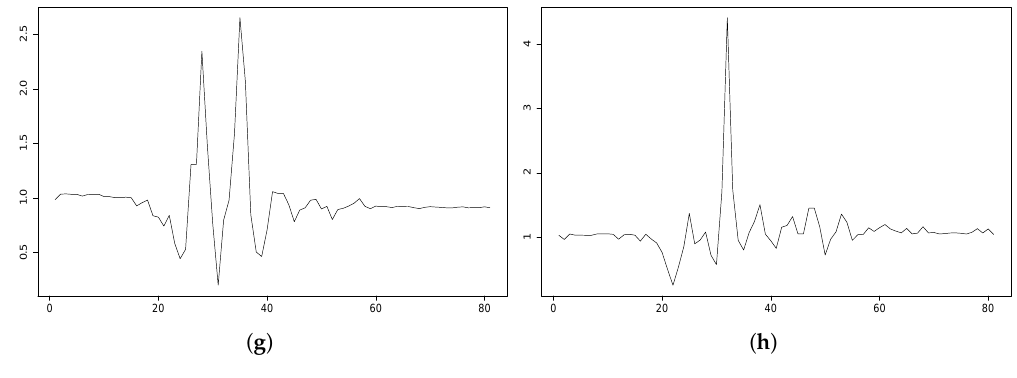
Figure 6. UMA Fall plots for some falls that behave differently from what was expected. The plots depict the magnitude of the acceleration during a fall in a period of 4 s (80 samples). The data come from the 3DACC sensor on the waist. ( a ) P1: forward fall, 3DACC ∈ [ 0.0,3.2 ] × g . ( b ) P1: backward fall, 3DACC ∈ [ 0.0,5.0 ] × g . ( c ) P12: lateral fall, 3DACC ∈ [ 0.0,2.8 ] × g . ( d ) P12: backward fall, 3DACC ∈ [ 0.0,2.0 ] × g . ( e ) P9: lateral fall, 3DACC ∈ [ 0.0,6.0 ] × g . ( f ) P9: forward